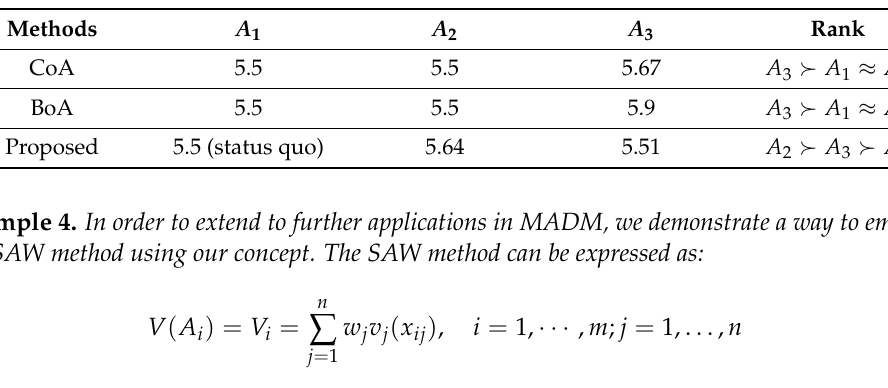
Table 5. The comparison of defuzzifying approaches in Example 3.